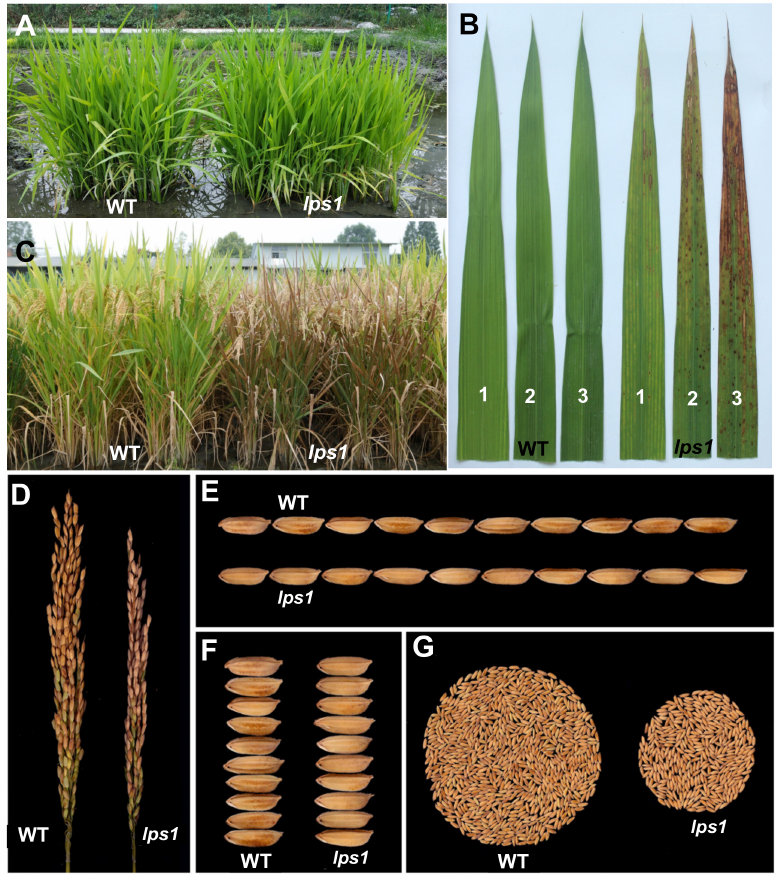
Figure 1. Phenotypic comparison between wild type (WT) and lps1 mutant. ( A ) The field phenotype at seedling stage. ( B ) The top three leaves at heading stage. One, 2 and 3 indicate flag leaf, the 2nd leaf and the 3rd leaf from the top, respectively. ( C ) The field phenotype at mature stage. ( D ) Panicle morphology. ( E ) Grain length. ( F ) Grain width. ( G ) Grain yield per